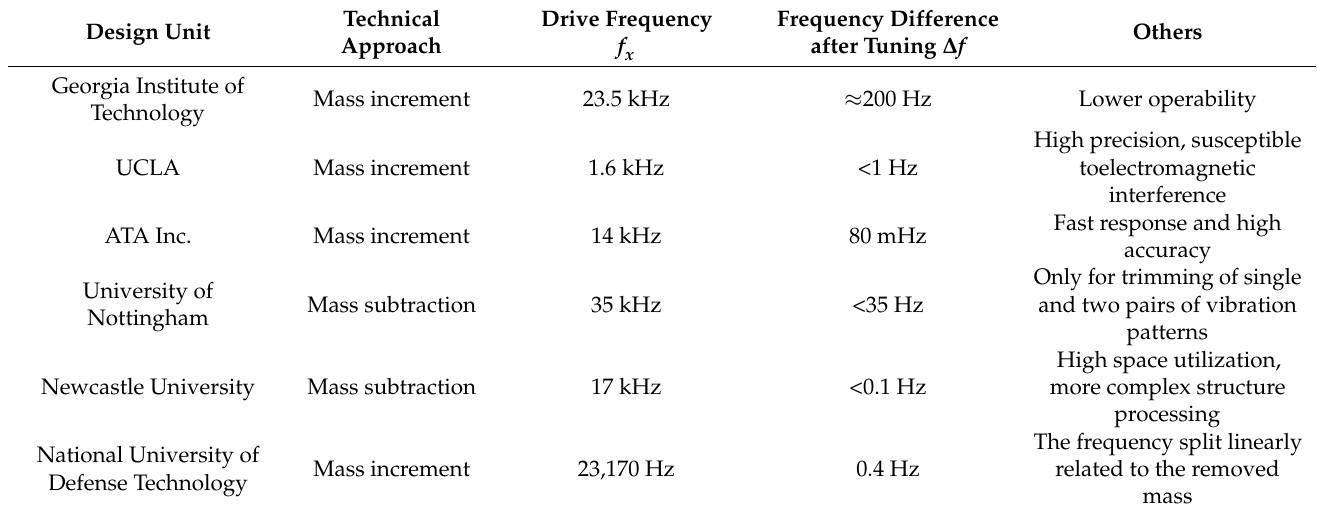
Table 1. Comparison of mode-matching schemes for structural mass augmentation and subtraction methods.